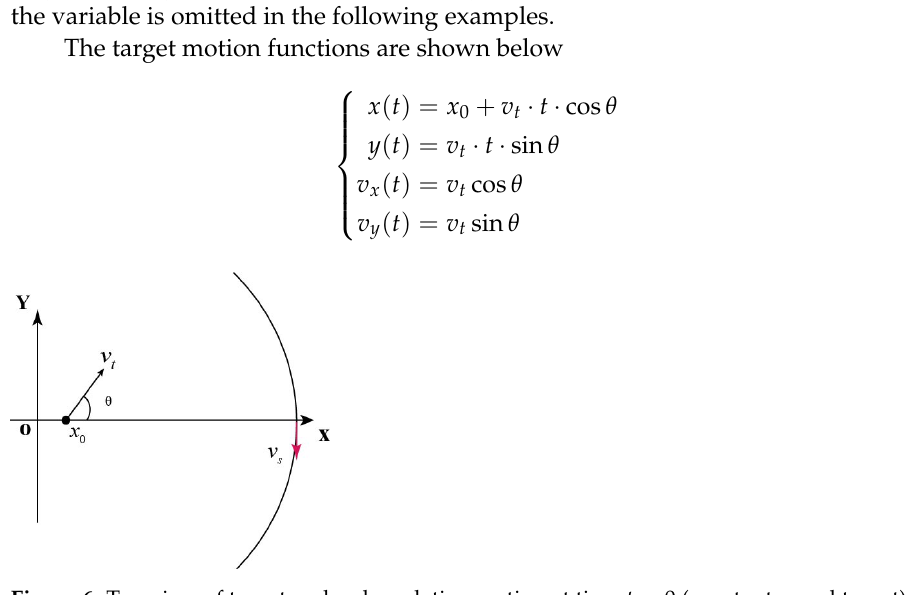
Figure 6. Top view of target and radar relative motion at time t = 0 (constant speed